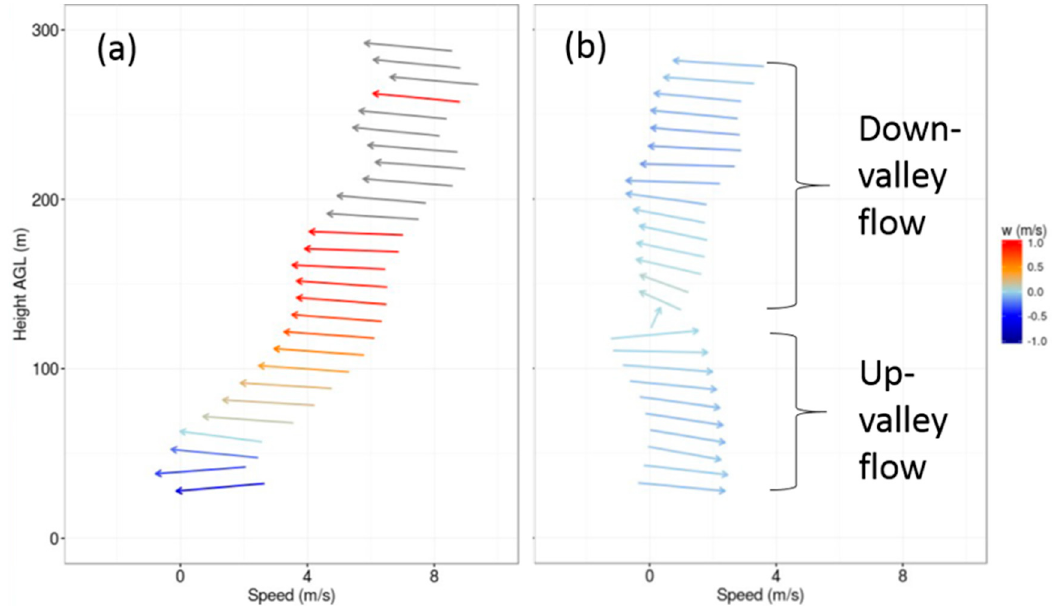
Figure 5. Vertical profiles of wind speed at 0900 LT measured by a sodar located at river level during: ( a ) a gap wind event on 17 Augus;t and ( b ) a non-event day on 18 August. The arrows are centered on the average speed measured at each height AGL. The direction of the arrow indicates the direction of the horizontal wind; arrows pointing left indicate wind from the east (downvalley wind). The arrow color indicates the w-component of the wind.